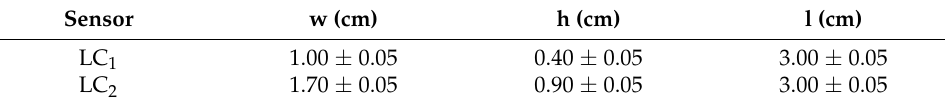
Table 1. Physical dimensions of the load cells LC 1 and LC 2 , where w, h and l are the width, height and length of each cell, respectively.